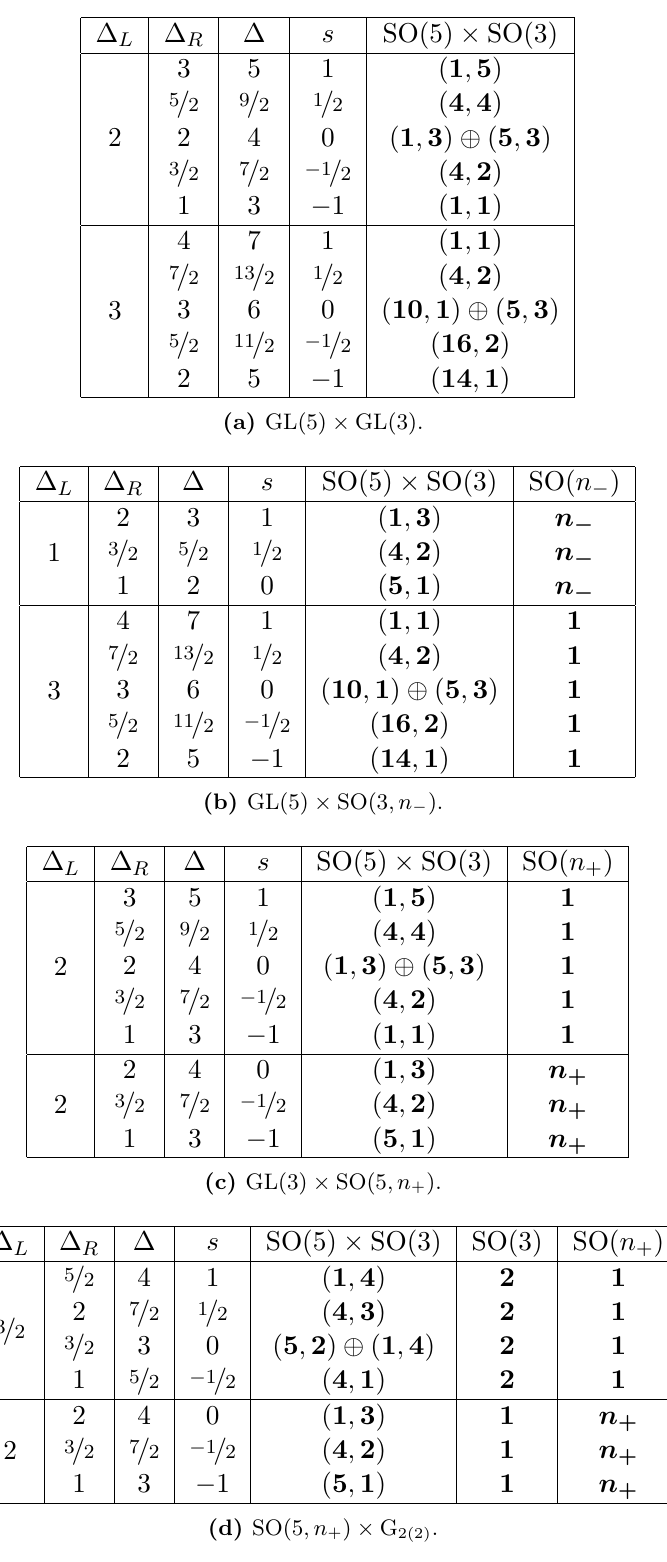
Table 18. Mass spectra for the OSp(4 (cid:3) j 4) solutions with diagonal embedding